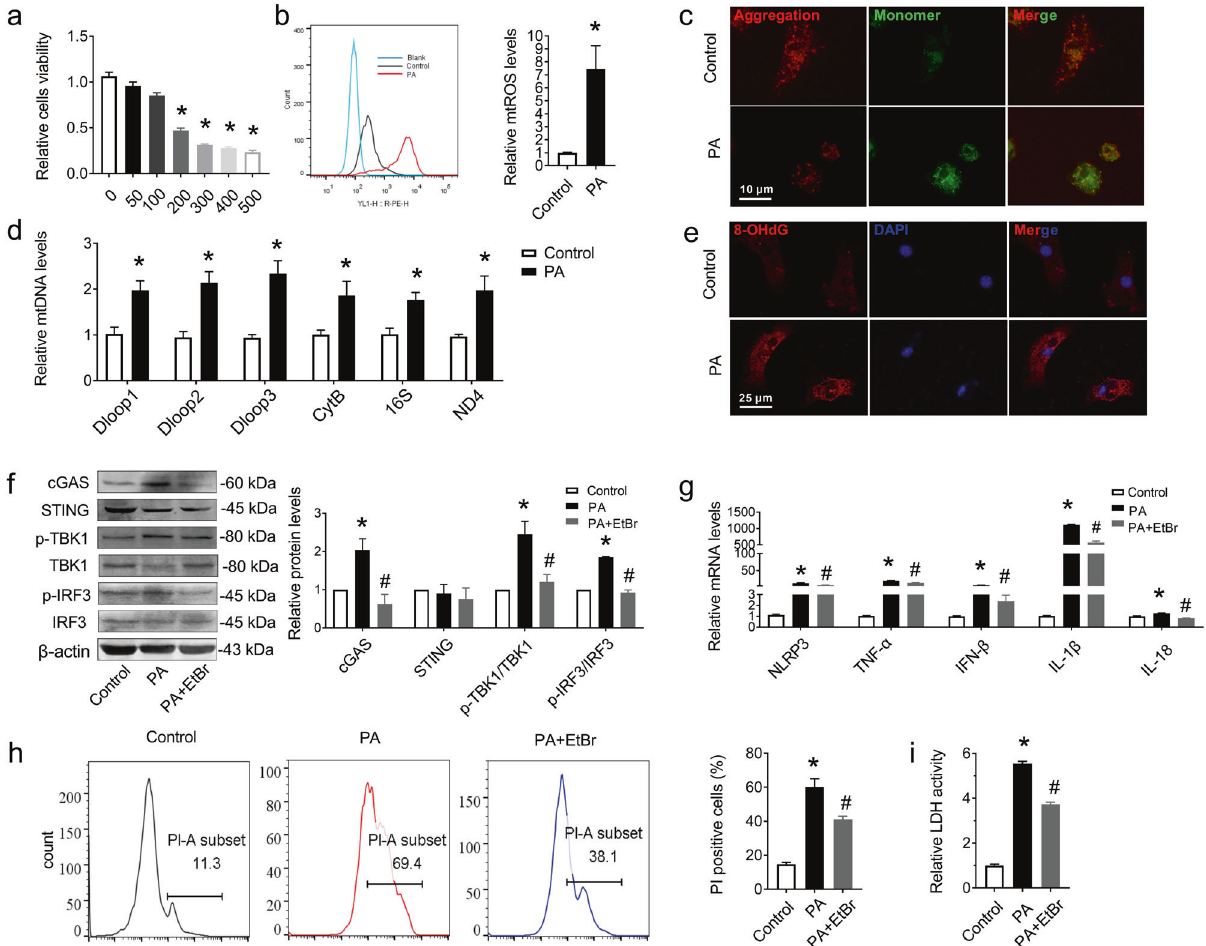
Fig. 4 PA activated cGAS-STING pathway in cardiomyocyte by induced mtDNA release and oxidative damage, leading to cell death. a Effect of PA on cardiomyocyte viability. H9C2 cells were incubated with different concentrations (50, 100, 200, 300, 400, or 500 μ M) of PA for 24 h and then assayed by cell counting kit-8. n = 5 in each group. b Representative fl ow cytometry image and quantitative analysis of the intracellular mtROS levels. n = 5 in each group. c Representative images of tetrachloro-tetraethyl benzimidazole carbocyanine iodide (JC-1) staining in NRCMs. n = 5 in each group. d mtDNA levels of Dloop1, Dloop2, Dloop3, CytB, 16S, and ND4 after treatment with or without PA in NRCMs. n = 5 in each group. e Oxidative guanine base damage of DNA was detected by fl uorescence-based immunocytochemistry using speci fi c antibodies for 8-OHdG in NRCMs. n = 6 in each group. f Western blot bands and analysis of cGAS, STING, p-TBK1/TBK1, and p-IRF3/ IRF3 after treatment with PA with or without EtBr in H9C2 cells normalized to β -actin. n = 3 in each group. g The mRNA levels of NLRP3, TNF- α , IFN- β , IL-1 β , and IL-18 in H9C2 cells. n = 3 in each group. h Representative fl ow cytometry image and the corresponding quanti fi cation showing the number of PI + cells in the pyroptosis population. Hoechst 33342/PI double staining was performed by fl ow cytometry to